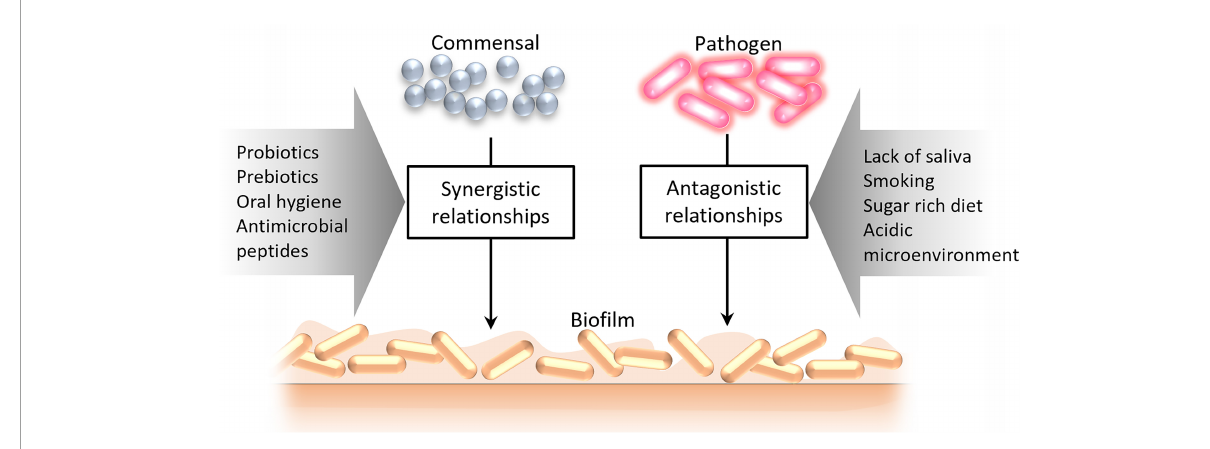
FIGURE3 Factors leading to the formation of synergistic and antagonistic relationships between oral